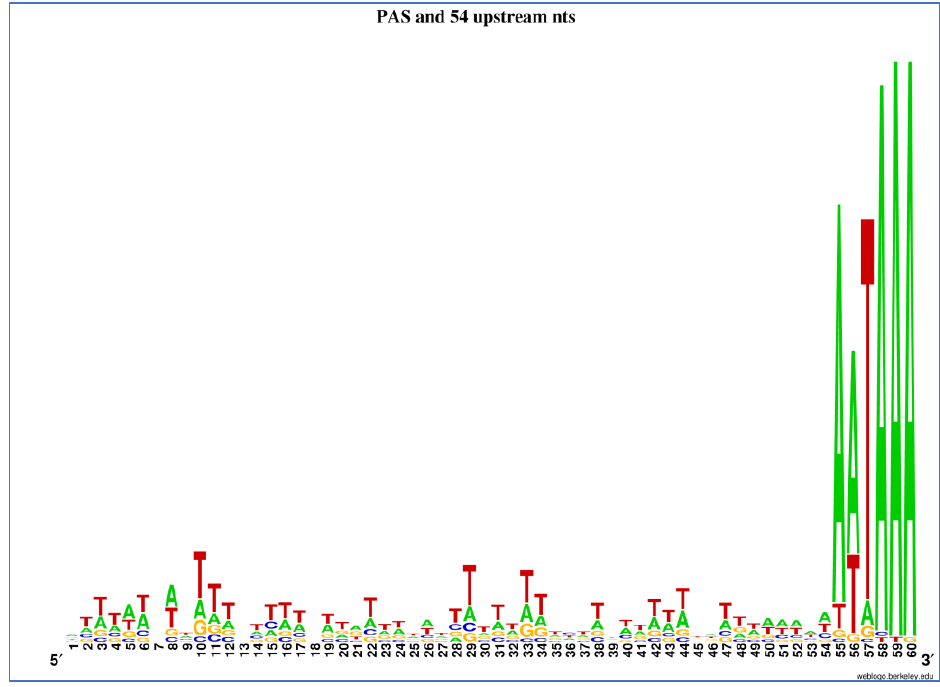
Figure 4. The PAS motif and the immediate nucleotides upstream of PAS in 100 transcripts.